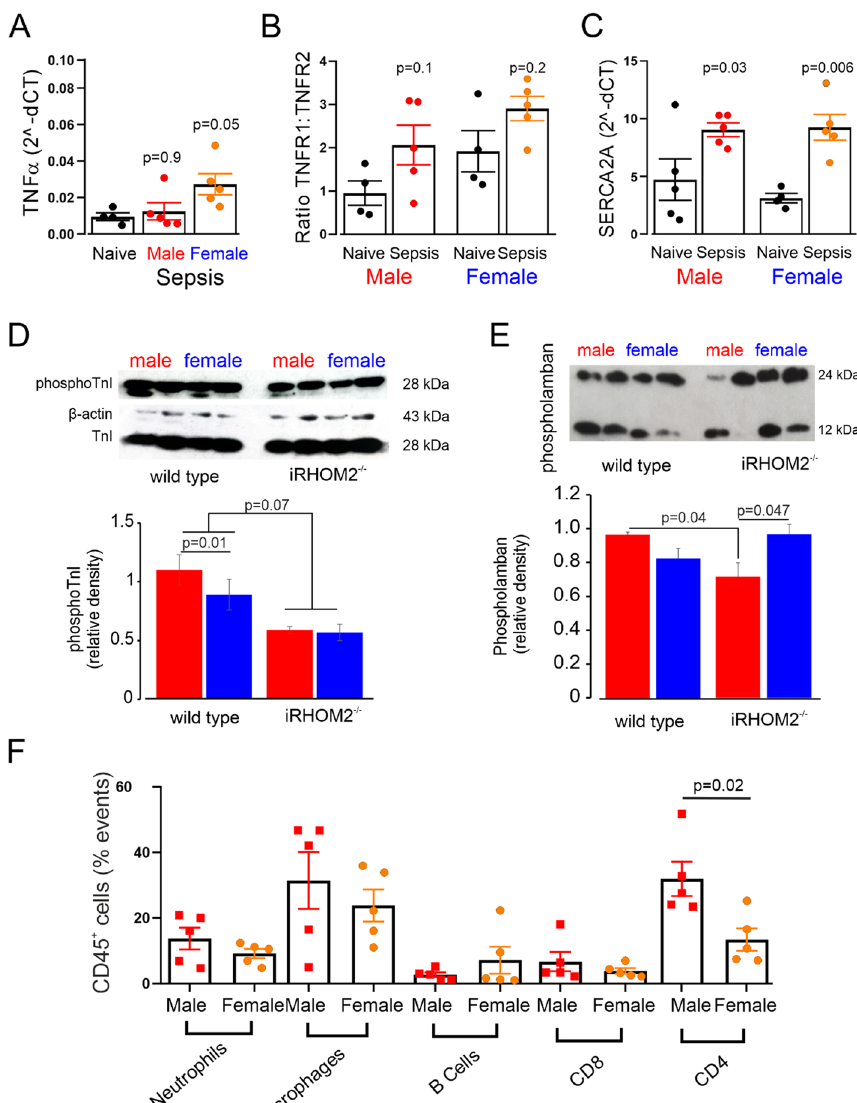
Fig. 9 Loss of TNFα shedding in iRHOM2 deficiency and cardiac inflammation and contractility after polymicrobial sepsis. A Cardiac TNFα gene transcription in naïve and septic RHOM2 deficient mice ( n 5/ = sex). B TNFR1/R2 ratio of mRNA expression in female and male iRHOM2-deficient mice before and after sepsis ( n 5/sex). C mRNA expression of sarco(endo)plasmic reticulum Ca2 ATPase 2 (SERCA2) female and male = + iRHOM2-deficient mice before and after sepsis ( n 5/sex). D Immunoblots showing comparison between = wild-type and knockout mice for phosphotroponin I protein expression 18 h after. Β -actin corrected values are compared in summary graph for 8/mice each sex. Individual p values on each panel refer to post hoc testing after ANOVA testing for sex x gene interaction. E Immunoblot for phospholamban protein expression in left ventricle 18 h after sepsis in wild-type male and female mice (original uncropped version in Additional file 1). Β -actin corrected values are compared in summary graph for 8/mice each sex. Individual p values on each panel refer to post hoc testing after ANOVA testing for sex x gene interaction. F A higher proportion of CD4 cells infiltrating the left ventricle in male iRHOM2 − / − mice (31.9 5.1% CD45 cells; n 5), compared + ± + = 0.02). Individual p values on each panel refer to post to 13.4 3.4% ( n 5) in female iRHOM2 − / − mice ( p = ± = hoc testing after ANOVA testing for sex x time